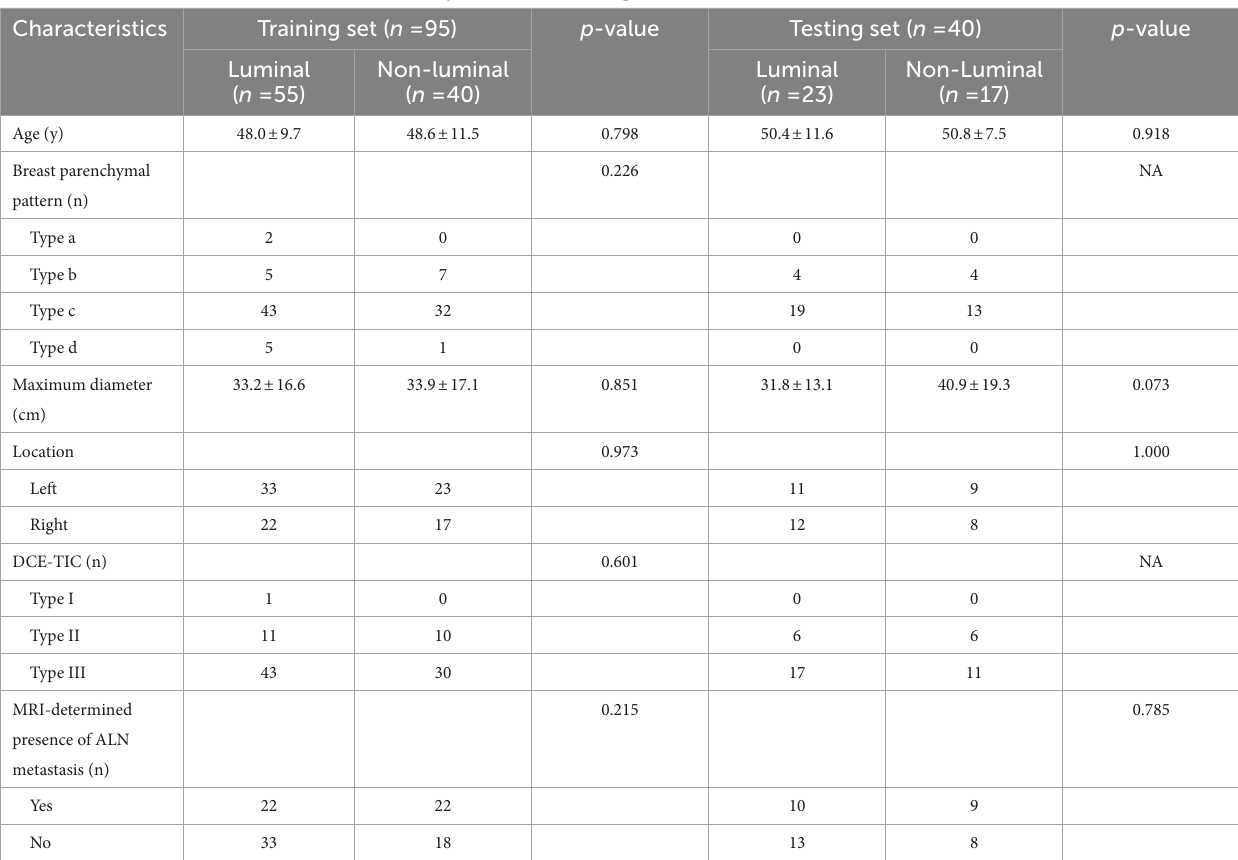
TABLE 2 Assessed clinical risk factors of breast cancer patients in the training and validation sets.